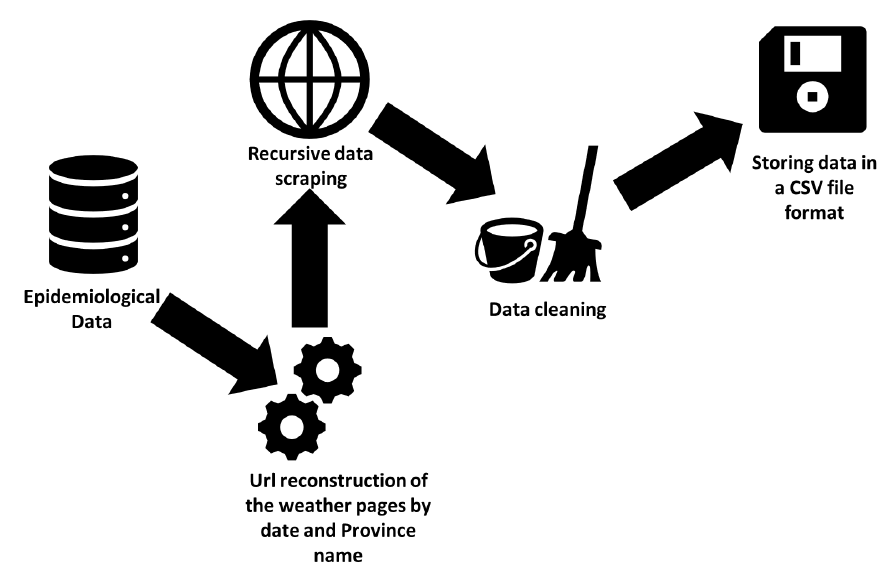
Figure 1. Weather data collection pipeline. A list of dates and Province names are extracted from the epidemiological data previously described. Then, the extracted province names are combined with all dates to reconstruct the URL of each page that contains relative information in the meteorological website. Data is extracted through data scraping, then raw data is normalized (e.g., by fixing inconsistency, providing uniformity of unit measurement for each date and province) and cleaned (e.g duplicate instances and redundant information removal, one-hot encoding of meteorological phenomena). Finally data is stored in a CSV file